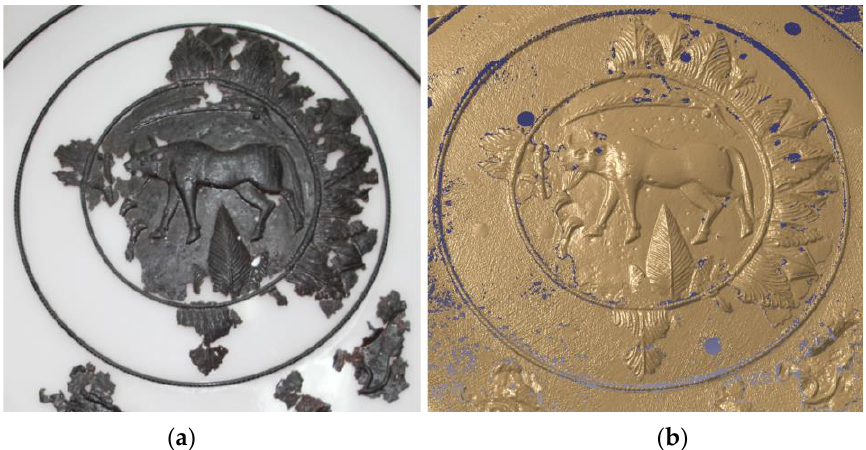
Figure 3. ( a ) A close-up photography of the physically realigned fragments; ( b ) 3D scan of the physically realigned fragments.